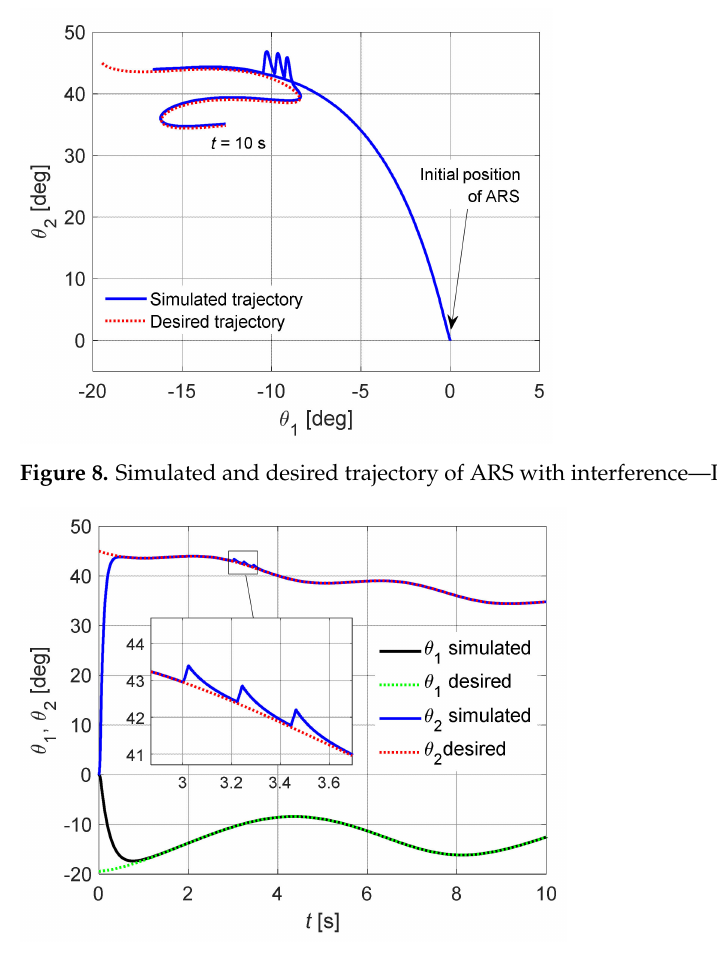
Figure 9. Angular displacements simulated and desired in azimuth and elevation with interference— LQR control.